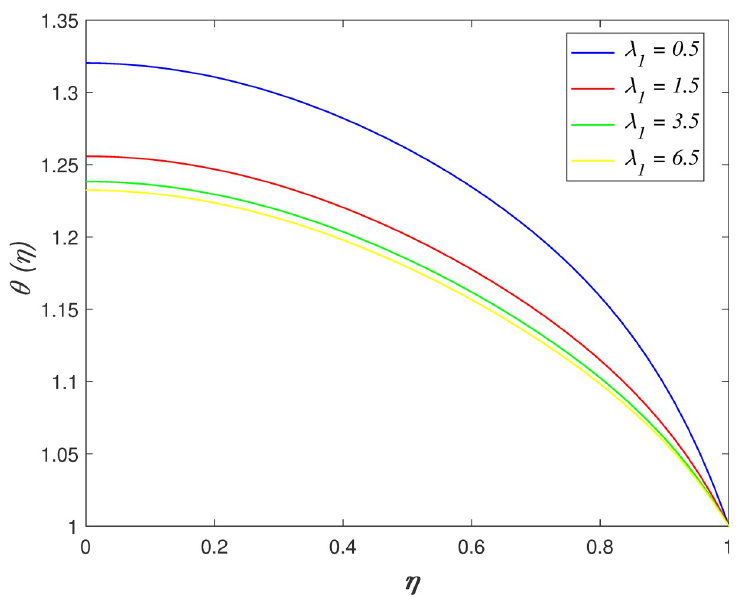
Fig 8. Impact of λ 1 on temperature.